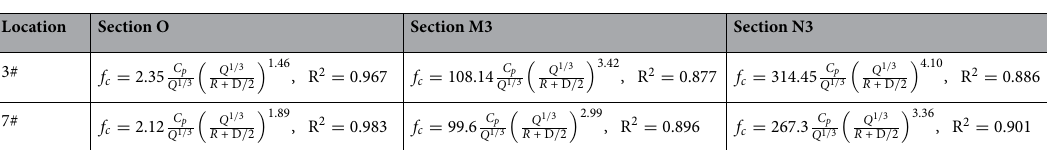
Table 4. f c fitting formula of measuring points 3# and 7# at different tunnel